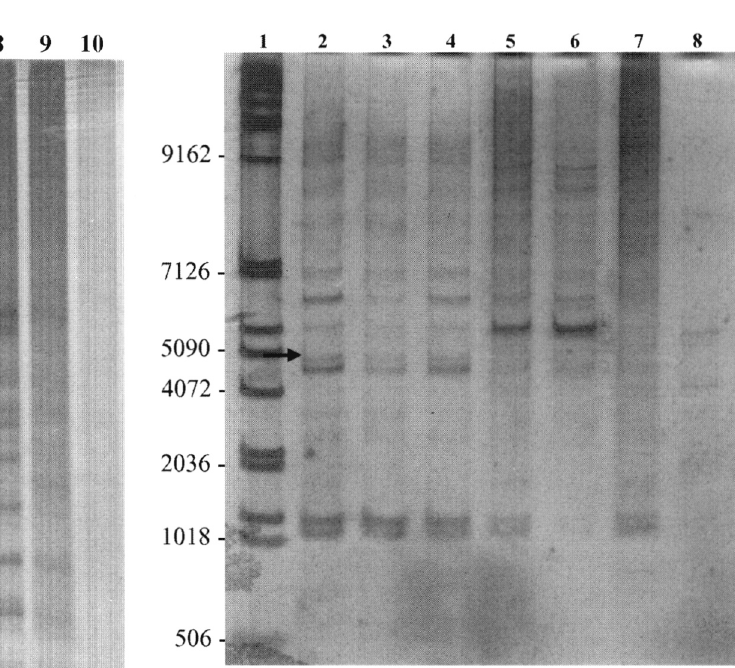
Fig. 4. - Random-amplified PCR from genomic DNA of Biompha­ laria tenagophila strains resistant and susceptible using arbitrary primer 10 (5’-GGTCCCTGAC-3’). Lane 1 (1-Kb DNA ladder); lane 2 (S1, susceptible); lane 3 (S2, susceptible); lane 4 (pool S, S1 and, S2); lane 5 (pool R, R1 and R2); lane 6 (R1, resistant); lane 7 (R2, resistant) and lane 8 (negative control, amplification without DNA). Samples were analyzed electrophoresis through a 8 % polyacryla­ mide gel and visualized by silver staining. Polymorphic band is indi­ cated by arrow.